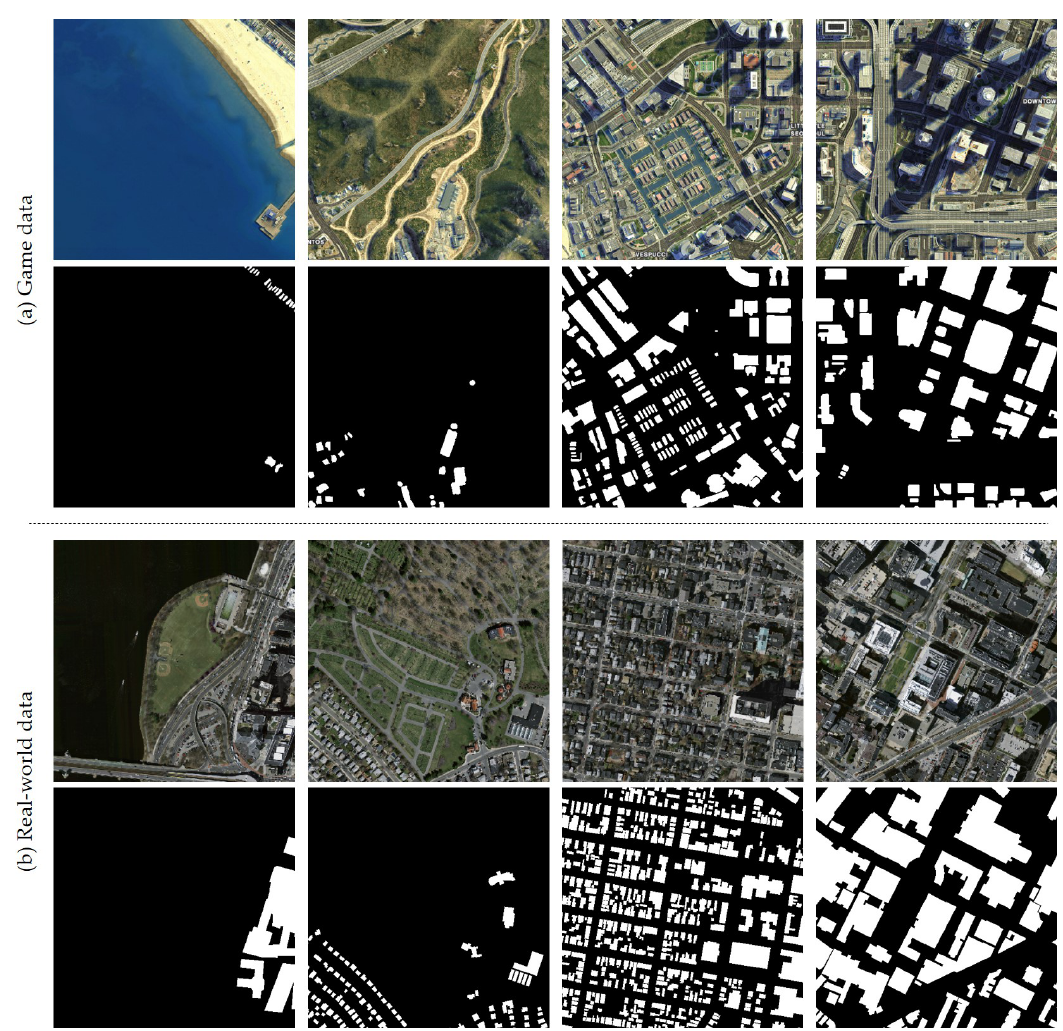
Figure 3. A preview of our two experimental datasets. ( a ) The first two rows show some representative images and their ground truth labels from our synthetic dataset (our training and validation set). ( b ) The last two rows show some image pairs from the real remote sensing dataset [30] (our testing